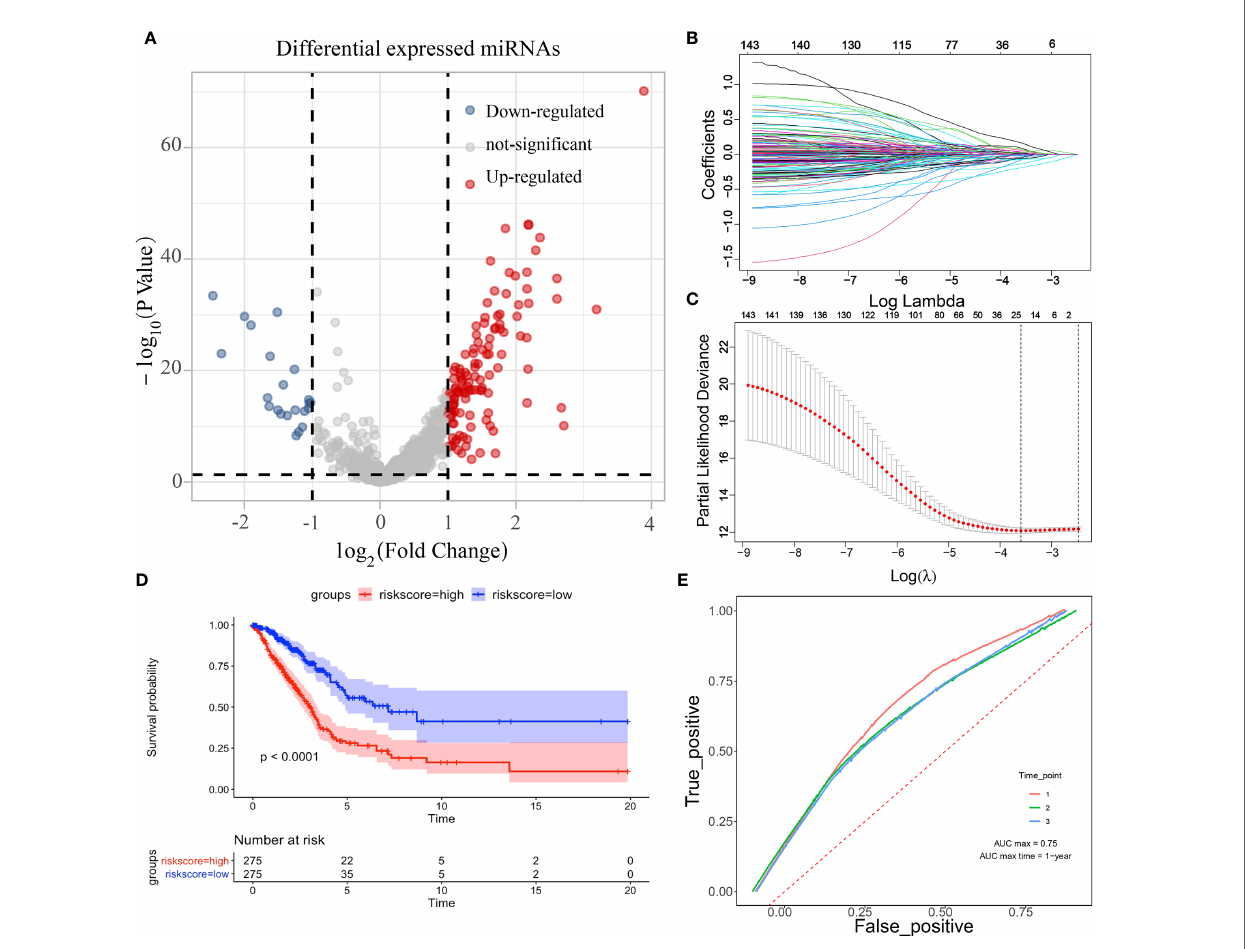
FIGURE 1 | Differential expression miRNA screening. ( A : volcano plot showing differentially expressed miRNAs; B : coef fi cients of selected features shown by lambda parameters; C : partial likelihood deviation versus log( l ); D : survival curves of high-and low-risk samples under LASSO regression; E ; ROC curves under LASSO